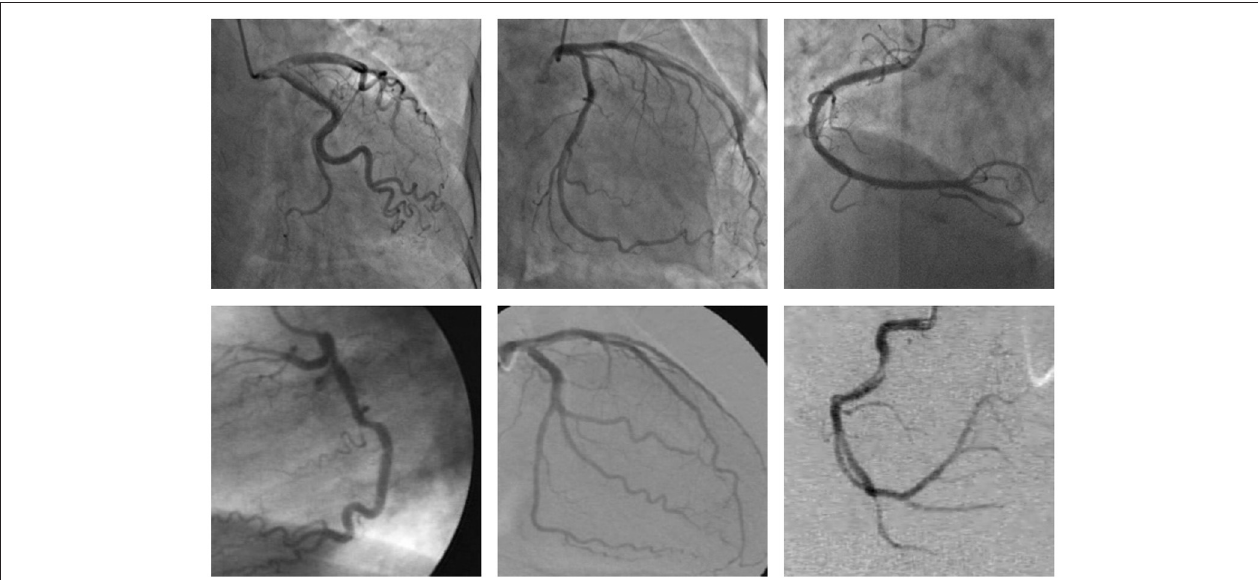
FIGURE 1 | These examples of the X-ray angiogram image with nonuniform illumination, low contrast ratios, and low signal-to-noise ratios. The images in the first row are selected from the clinical coronary angiograms dataset, while the second row of the data is from the Database X-ray Coronary